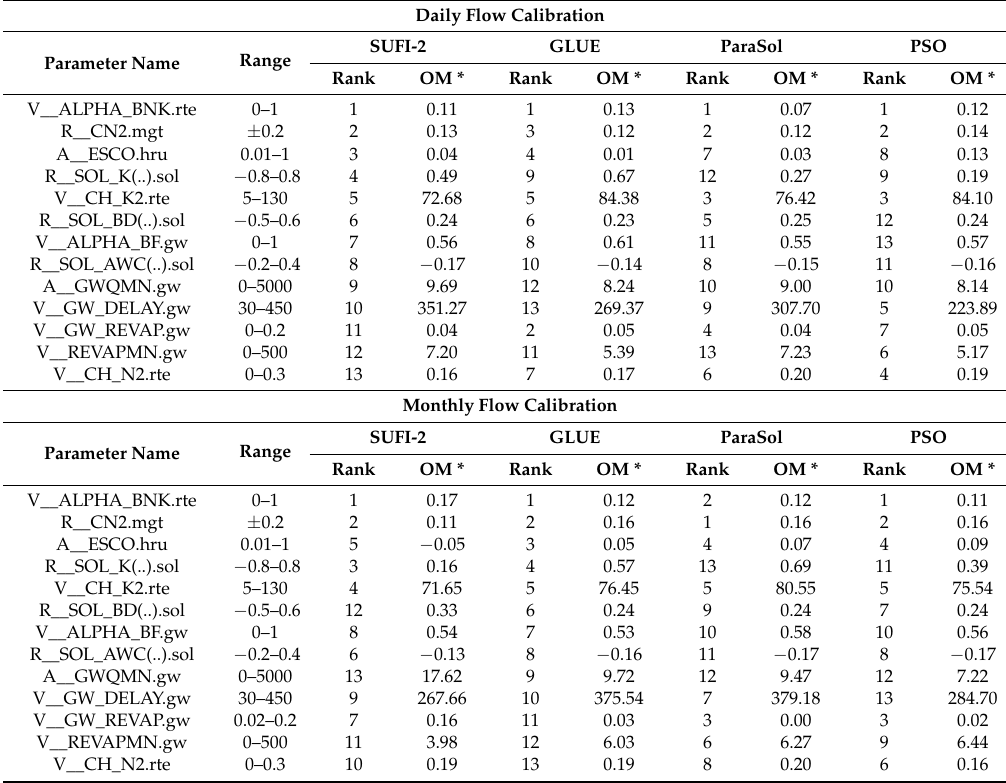
Table 3. Calibration flow parameter statistics: lower and upper boundary, global sensitivity, and optimized parameter values using SUFI-2, GLUE, ParaSol, and PSO uncertainty